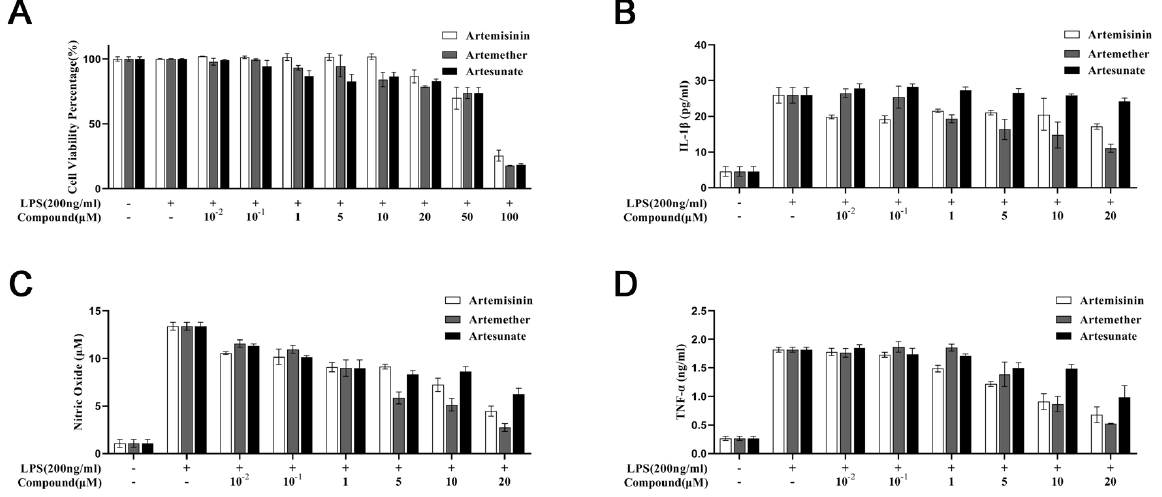
Figure 2. Effects of artemisinin, artesunate, and artemether on ( A ) cell viability, ( B ) interleukin-1 β (IL-1 β ), ( C ) nitric oxide, and ( D ) tumor necrosis factor- α (TNF- α ) production in lipopolysaccharide (LPS) treated BV2 microglial